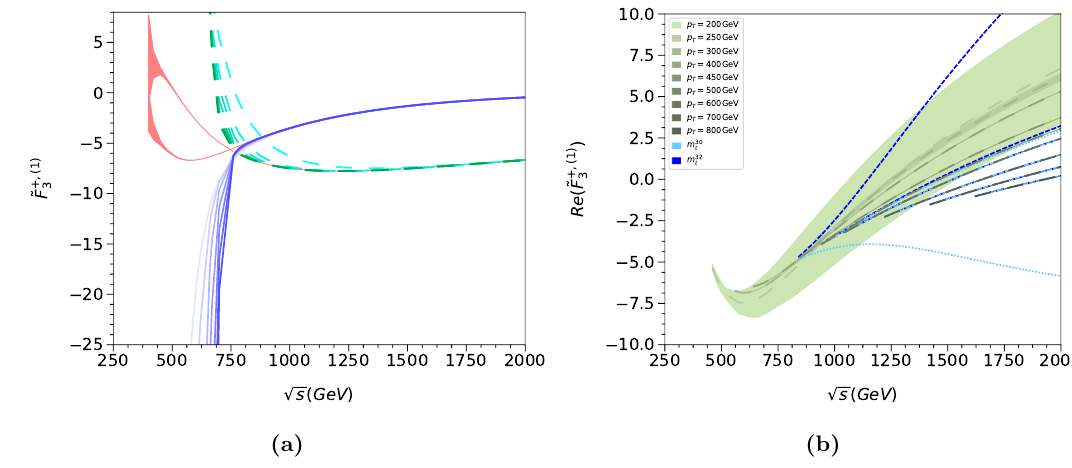
√ Figure 3. Results for ˜ F + as a function of s for fixed θ = π/ 2 (a) and for fixed p T (b). In (a) 3 dashed and solid lines correspond to the imaginary and real parts, respectively. The red curves in (a) represent the Padé results. In (b) only the real part is shown, and the Padé results are shown as green dashed lines. The high-energy expansions up to order m 30 and m 32 are shown in blue. The t t widely-separated pair of curves correspond to p T = 400